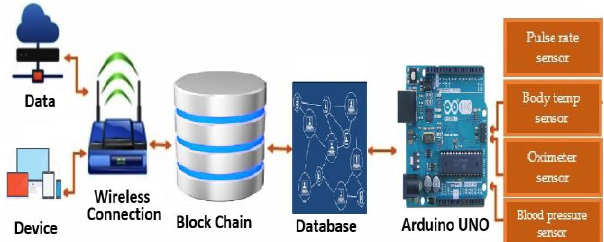
Figure 4. Proposed WBANs